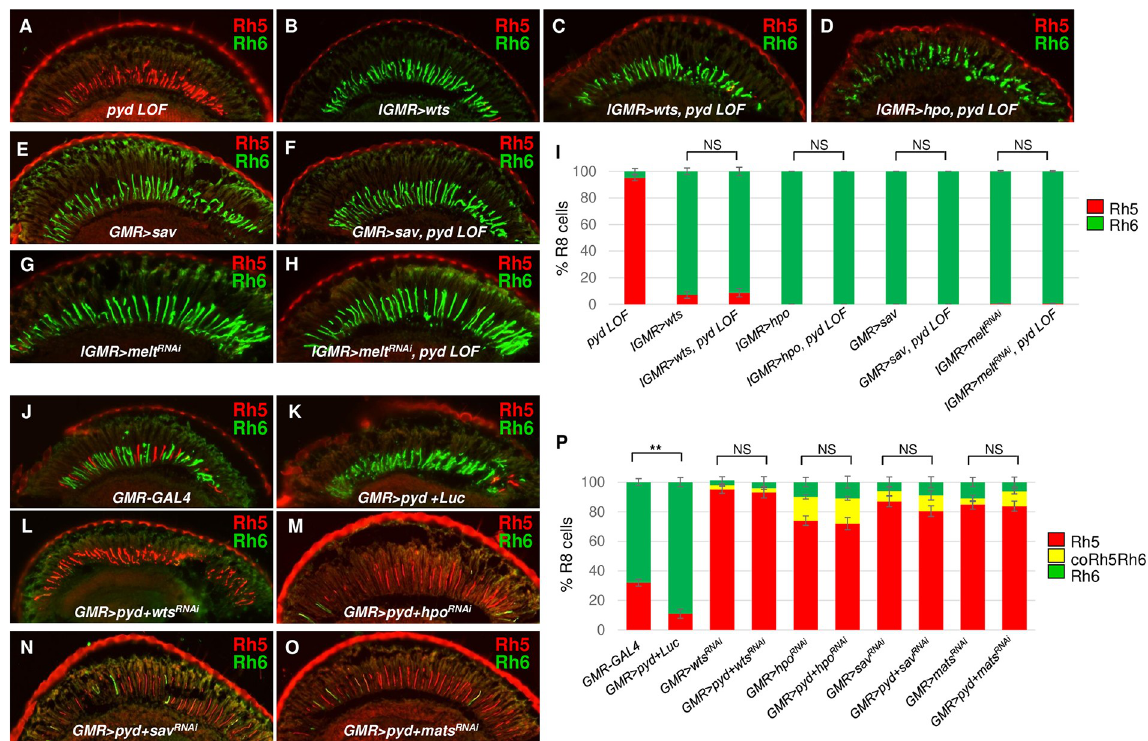
Fig 5. Pyd functions upstream of the core components of the Hippo pathway for R8 subtype fate specification. (A-H) Cryosections of adult eyes in which wts , hpo , sav or melt were genetically manipulated as indicated in pyd LOF flies were stained for Rh5 (red) and Rh6 (green). LOF = loss-of-function. Genotypes are: (A) pyd ex180 /pyd B12 , (B) lGMR > wts , (C) lGMR > wts , pyd ex180 /pyd B12 , (D) lGMR > hpo , pyd ex180 /pyd B12 , (E) GMR > sav , (F) GMR > sav , pyd ex180 /pyd B12 , (G) lGMR > melt RNAi , (H) lGMR > melt RNAi , pyd ex180 /pyd B12 . Refer to Supporting Information S1 Text for detail genotypes. (I) Quantification of Rh5- and Rh6-expressing R8s in the eyes with the indicated genotypes. y axis presents proportion of R8s that express Rh5 (red) or Rh6 (green). Error bars represent standard deviation. NS: not significant. pyd LOF: n = 10 retinas, n = 1902 R8s; lGMR > wts : n = 6 retinas, n = 1005 R8s; lGMR > wts , pyd LOF : n = 6 retinas, n = 1033 R8s; lGMR > hpo : n = 4 retinas, n = 823 R8s; lGMR > hpo , pyd LOF: n = 4 retinas, n = 801 R8s; GMR > sav : n = 4 retinas, n = 922 R8s; GMR > sav , pyd LOF: n = 4 retinas, n = 889 R8s; lGMR > melt RNAi : n = 4 retinas, n = 1134 R8s; lGMR > melt RNAi , pyd LOF: n = 4 retinas, n = 1201 R8s. (J-O) Cryosections of adult eyes stained for Rh5 (red) and Rh6 (green) in flies with the indicated genotypes. Genotypes are: (J) GMR-GAL4 , (K) GMR > pyd+Luc , (L) GMR > pyd+wts RNAi